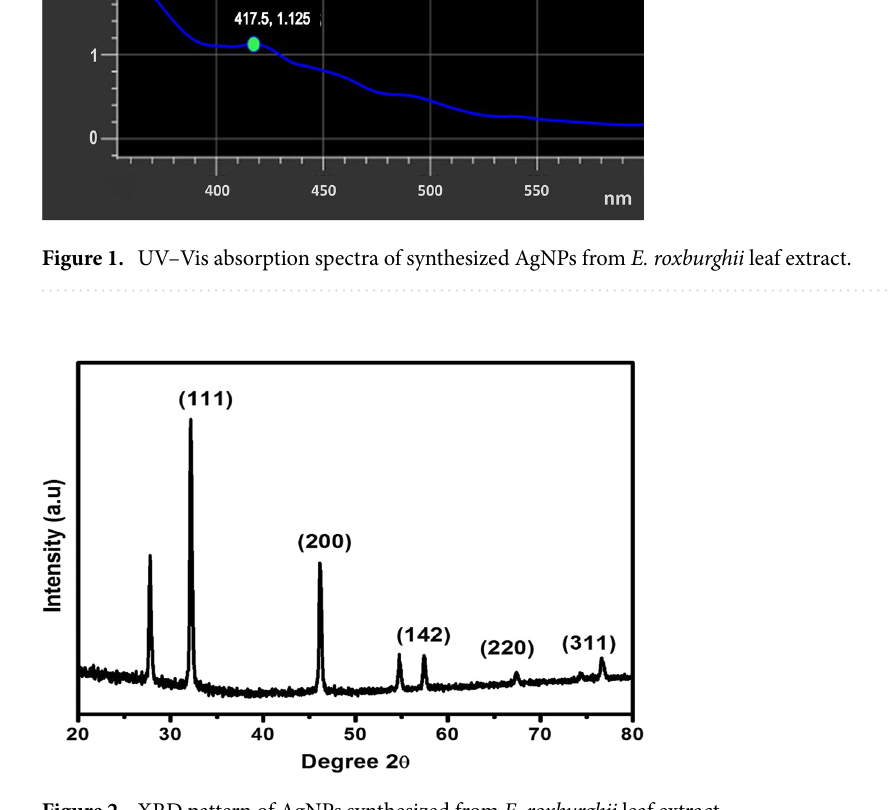
Figure 2. XRD pattern of AgNPs synthesized from E. roxburghii leaf